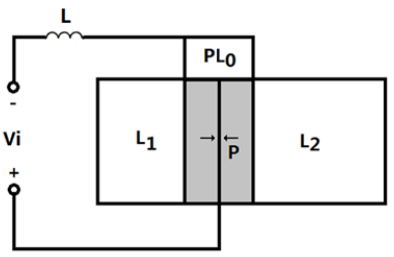
Figure 3. Geometrical sketch of a sandwiched piezoelectric transducer with a series inductor.